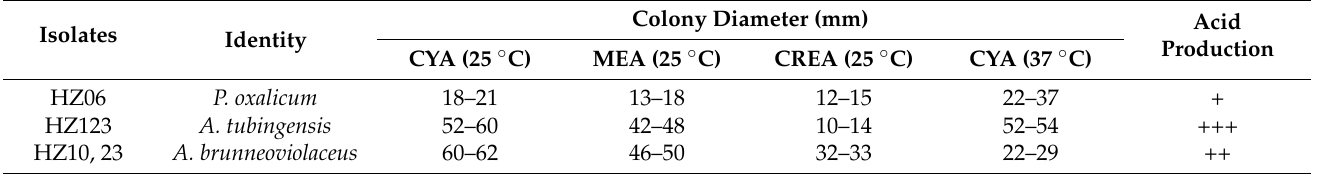
Table 1. Colony diameter and organic acid production of four fungal isolates on different media.